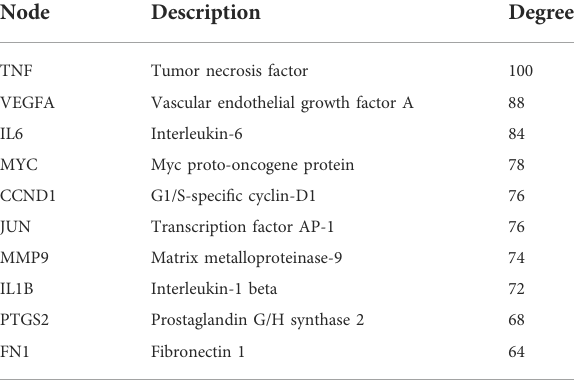
TABLE 1 The hub genes from the PPI